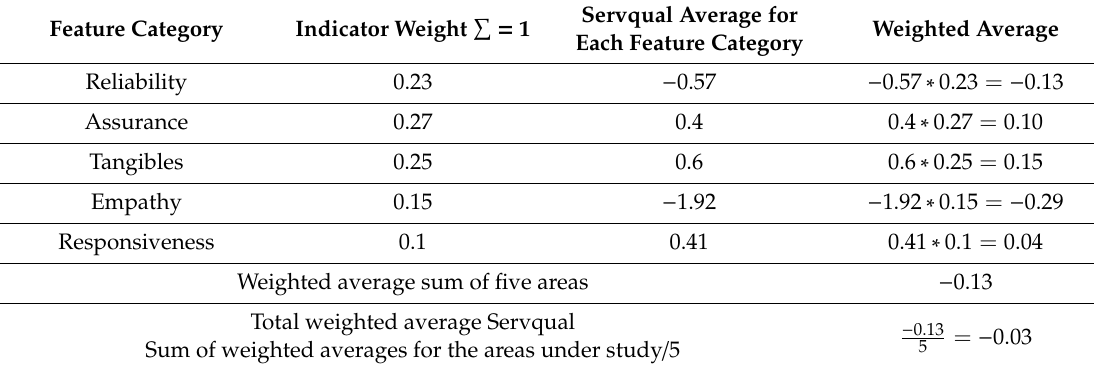
Table 4. Weighted averages for the Servqual analysis.